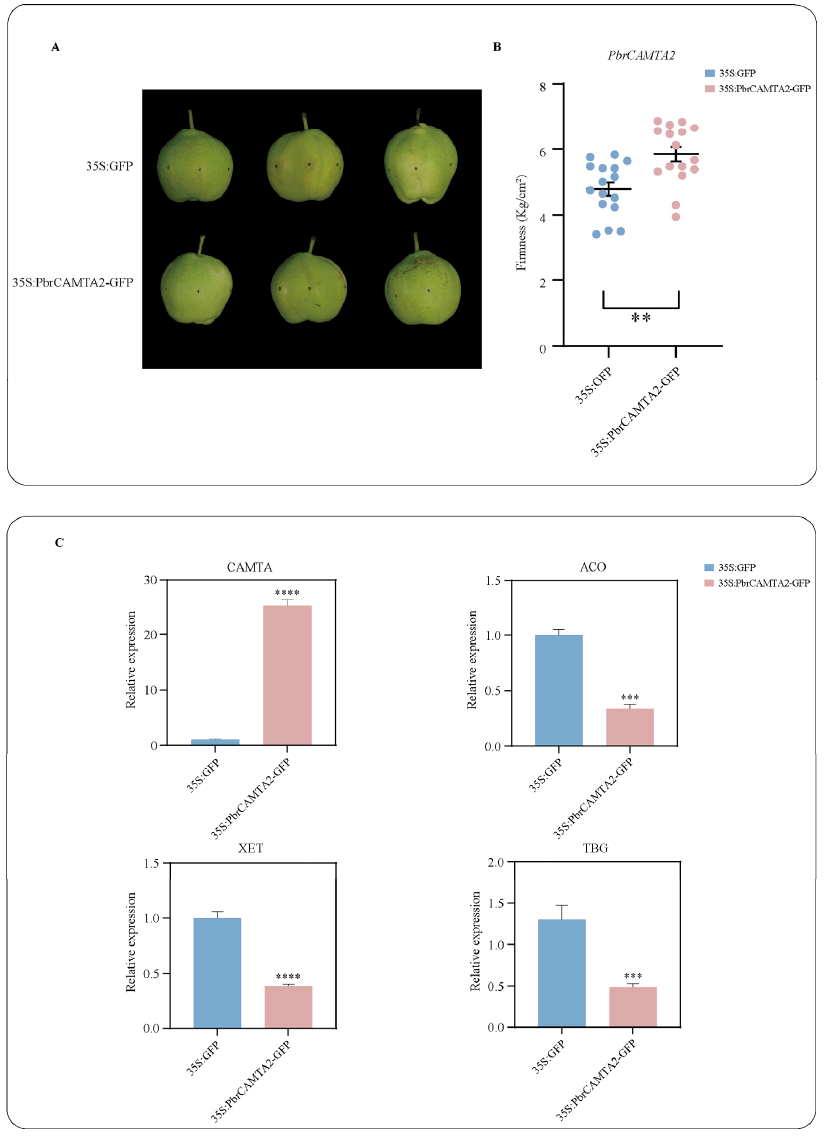
Figure 8. Transient assays by overexpressing PbrCAMTA2 in ‘Zaosu’ pear fruit 110 DAFB. ( A ) Phenotypes of pear fruits. Images were taken five days after agro-infiltration. ( B ) The firmness of fruits.